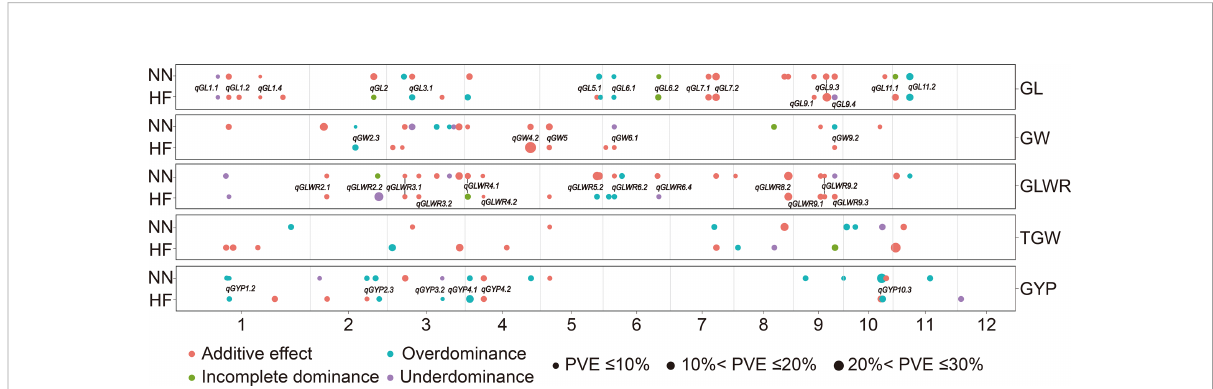
FIGURE 1 Genomic distributions of 114 mQTL for grain shape and grain weight as well as grain yield traits identi fi ed in the RILs, BC 1 F 1 s, and H MP s in Hefei (HF) and Nanning (NN). QTL represented in the fi gure were those stably identi fi ed in both environments. GL, grain length; GW, grain width; GLWR, grain length-width ratio; TGW, 1000-grain weight; GYP, grain yield per